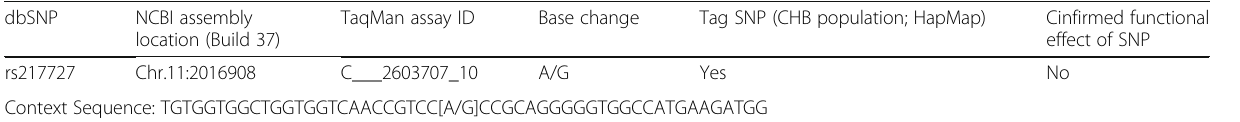
Table 1 Genotyped SNP ordered according to the position in the H19 gene dbSNP NCBI assembly TaqMan assay location (Build 37)